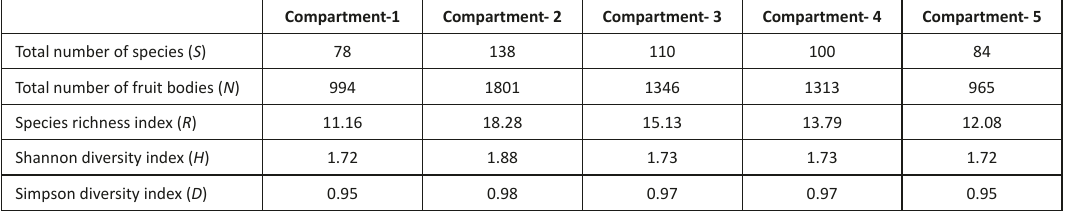
Table 2. Diversity analysis in five compartments of HGWLS ( R : species richness, H_ : Shannon diversity index, D : Simpson diversity index).